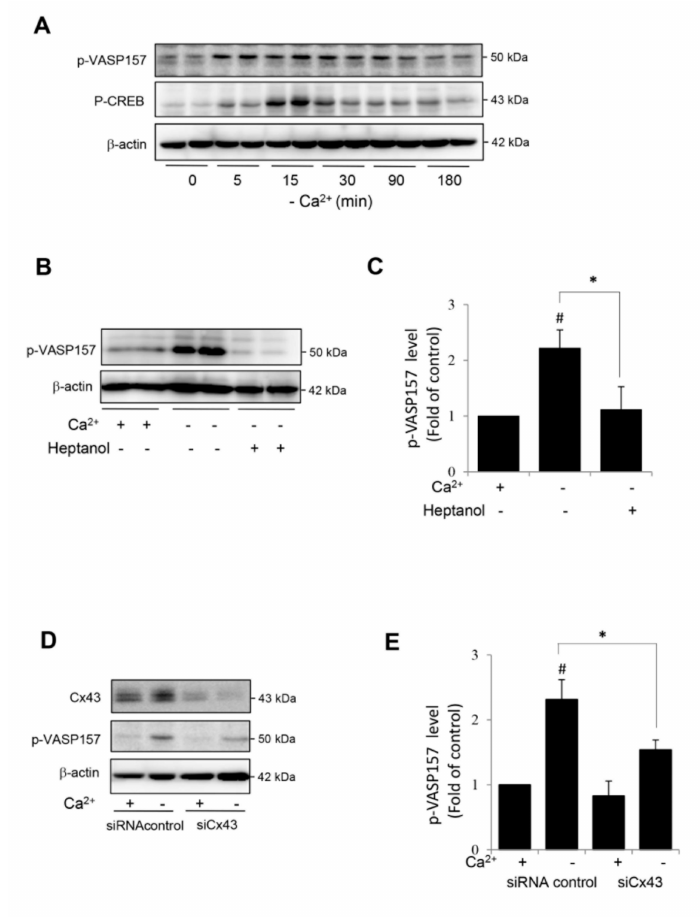
Figure 5. Hemichannel-mediated activation of cAMP signaling pathway in renal tubular epithelial NRK cells. ( A ) Induction of VASP and CREB phosphorylation by Ca 2 + deprivation in NRK cells. NRK cells were exposed to Ca2 + -free medium for the indicated time intervals. Cellular proteins were extracted and subjected to Western blot analysis for phosphorylated level of VASP and CREB. β -actin was used as a loading control. ( B – E ) E ff ect of hemichannel inhibitor heptanol ( B , C ) and Cx43 siRNA treatment ( D , E ) on PKA activation. NRK cells were pretreated with 3 mM heptanol for 30 min ( B ) or Cx43 siRNA for 48 h ( D ) before exposing to Ca 2 + -free medium for 10 min. Cellular proteins were extracted and subjected to Western blot analysis for phosphorylated level of VASP and β -actin. ( C , E ) Densitometric quantitation of the phosphorylated level of VASP in B and D, respectively. The intensities of p-VASP signal were measured by using the Scion Image software. The data are expressed as relative intensity of the band against the control (mean ± SE, n = 4). # p < 0.05 versus normal Ca 2 + control; * p < 0.05 versus heptanol or siRNA-treated